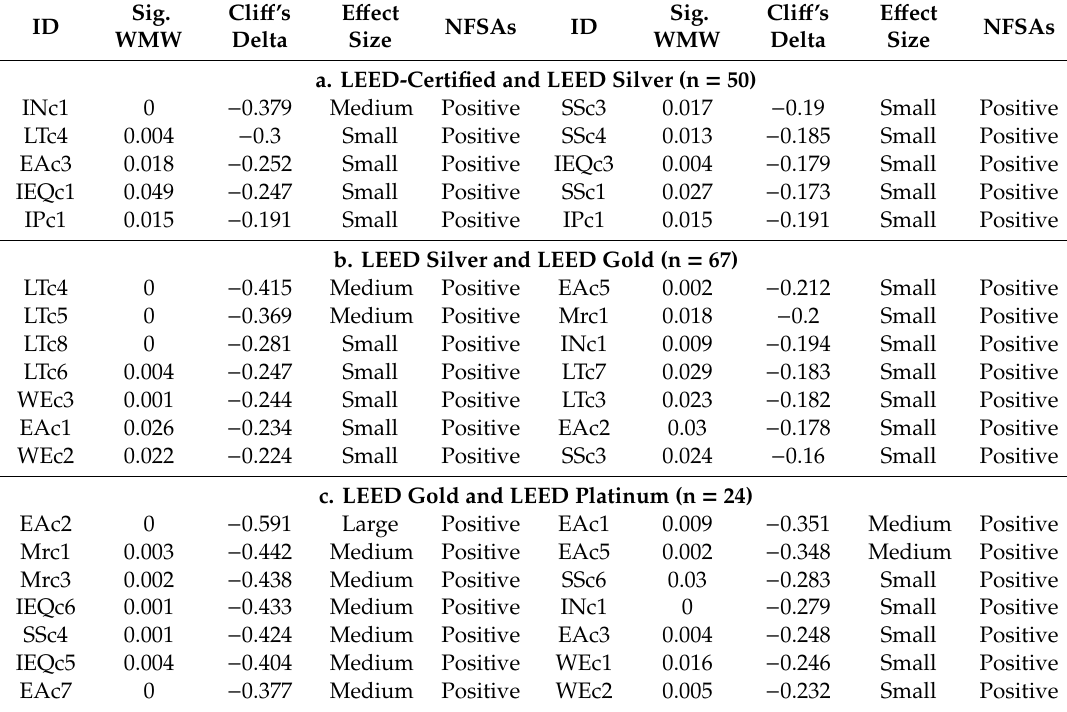
Table 3. The results of the Wilcoxon–Mann–Whitney (WMW) test and Cli ff ’s delta indexes between adjacent pairs of Leadership in Energy and Environmental Design (LEED) certificate levels.